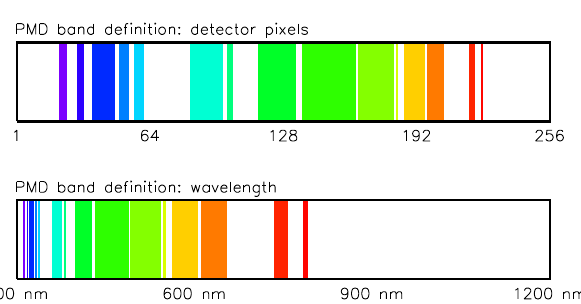
Figure 1. Illustration showing the spectral coverage of the fifteen GOME-2 PMD bands, on the PMD detector arrays (top bar), and on the wavelength grid (bottom bar). The PMD RAW mode in principle covers the entire GOME-2 wavelength range between 300 and 800 nm with a spectral resolution ranging between 3 nm in the UV up to 35 nm in the NIR.